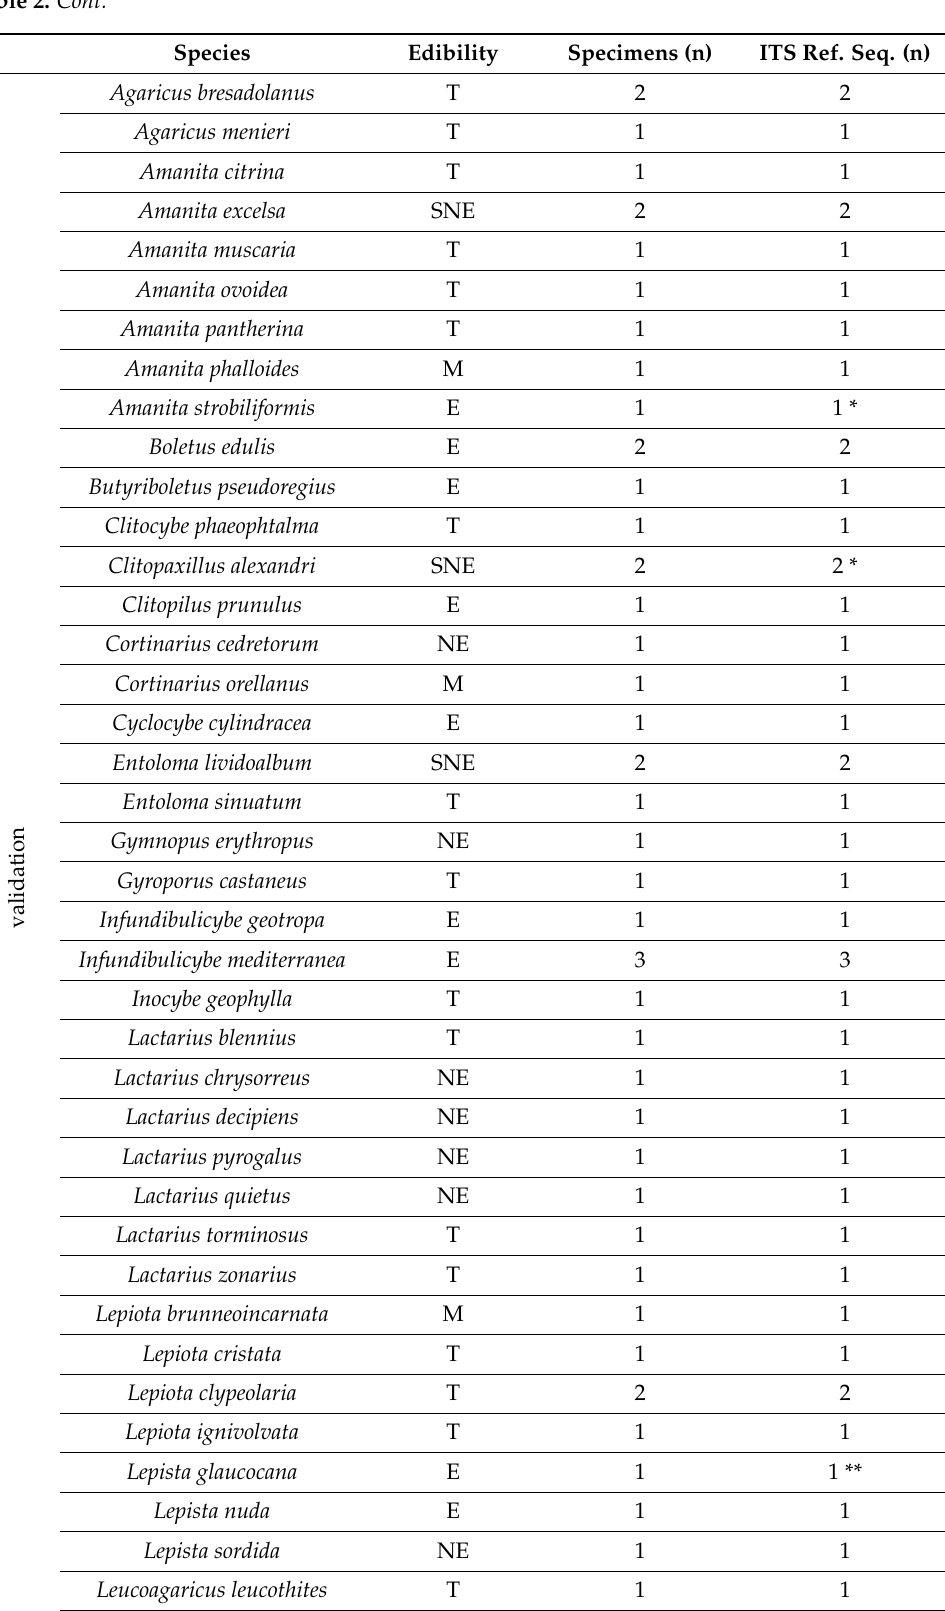
Table 2. Cont. Species Edibility Specimens (n) ITS Ref. Seq.